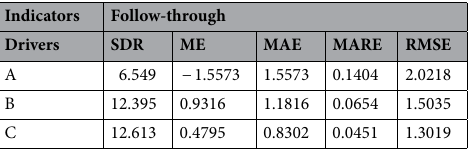
Table 6. FTP75 working conditions corresponding to the three types of driver following behavior model evaluation index.